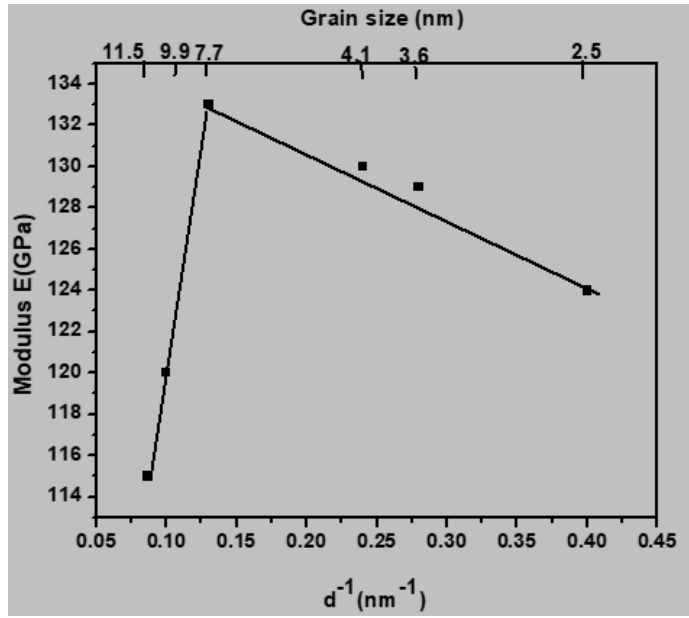
Figure 9. Young’s modulus E as a function of reciprocal grain size d −1 at 300 K.